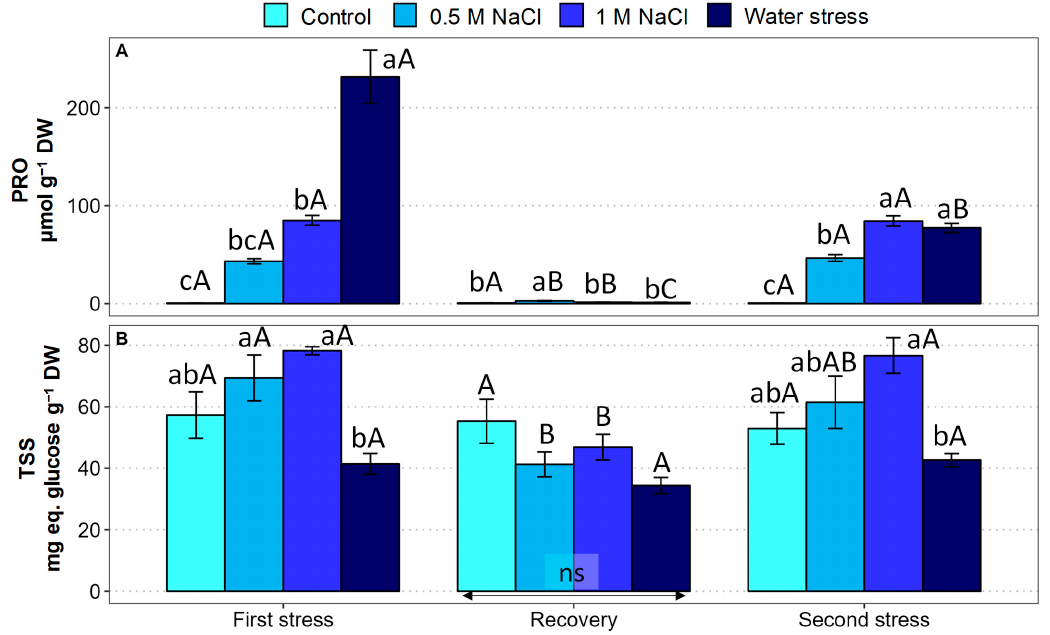
Figure 5. Effect of 30 days of stress treatment (First stress), followed by 15 days of watering with non ‐ saline water (Recovery) and by additional 15 days of stress (Second stress) on the leaf concentrations of osmolytes in Limonium angustebracteatum plants. ( A ) Proline (PRO) and ( B ) Total Soluble Sugars (TSS). Different lowercase letters over the bars indicate significant differences between treatments (Control, 0.5 M NaCl, 1 M NaCl, and Water stress) for each sampling, at p ≤ 0.05; ns: non ‐ significant. Different uppercase letters indicate significant differences between the three sampling times (First stress, Recovery, and Second stress) for each treatment, at p ≤ 0.05; NS: non ‐ significant. Vertical bars indicate standard error (n = 4).